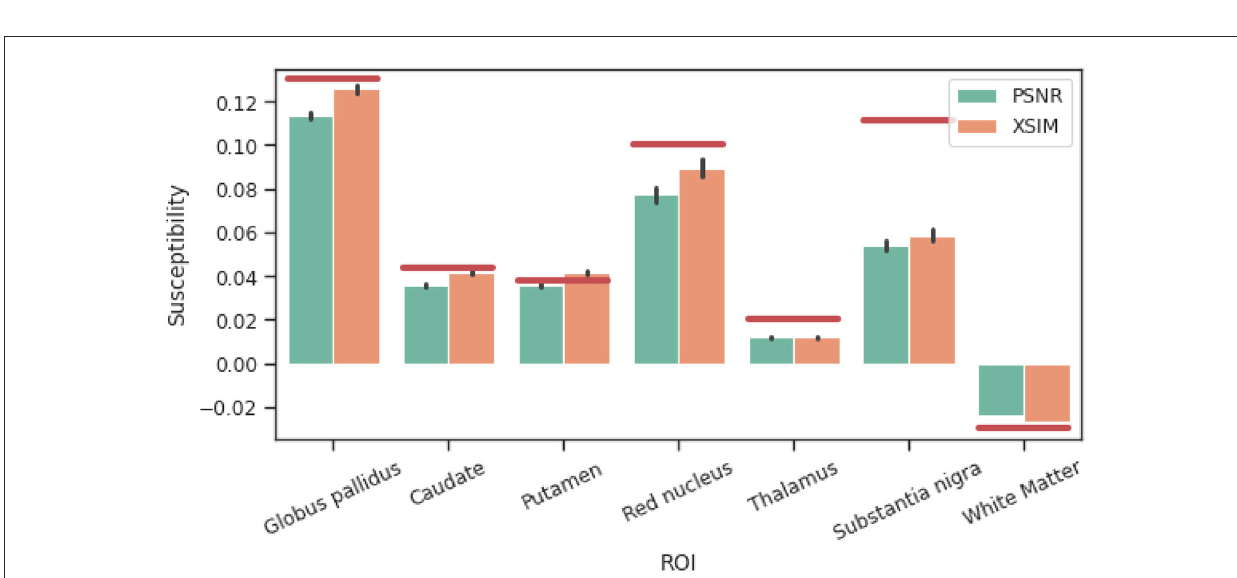
FIGURE4 Comparison between XSIM-optimal and PSNR-optimal reconstructed susceptibility values (using the incomplete spectrum approach) for deep gray matter regions of interest in the challenge phantom. Red lines are ground truth susceptibility values, and vertical black lines signify 3 standard errors.